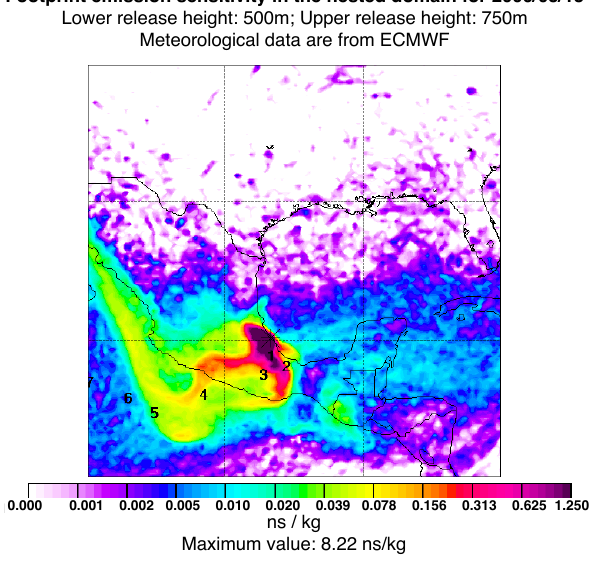
Fig. 4. Emission sensitivity footprint for the 500–750m altitude range at our AAC scene obtained from FLEXPART driven by me- teorological data from